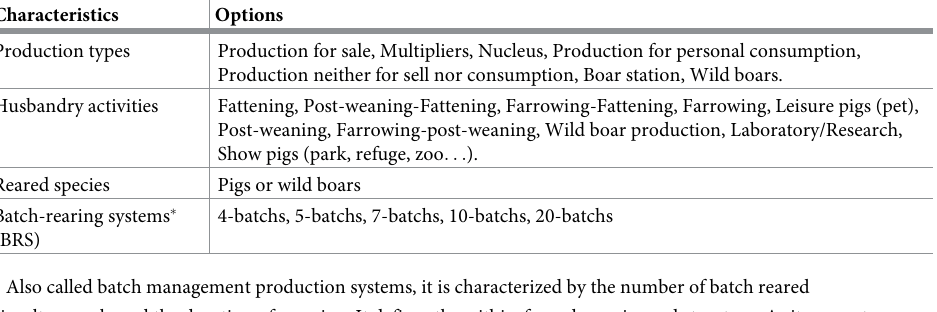
Table 1. Details of holdings